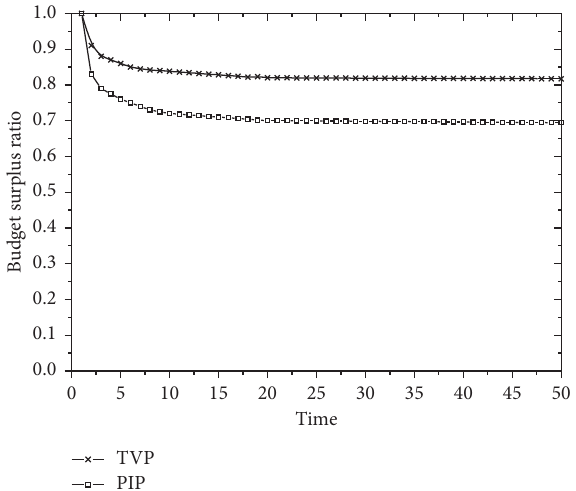
Figure 6: Task type where utility is inversely proportional to task progress.